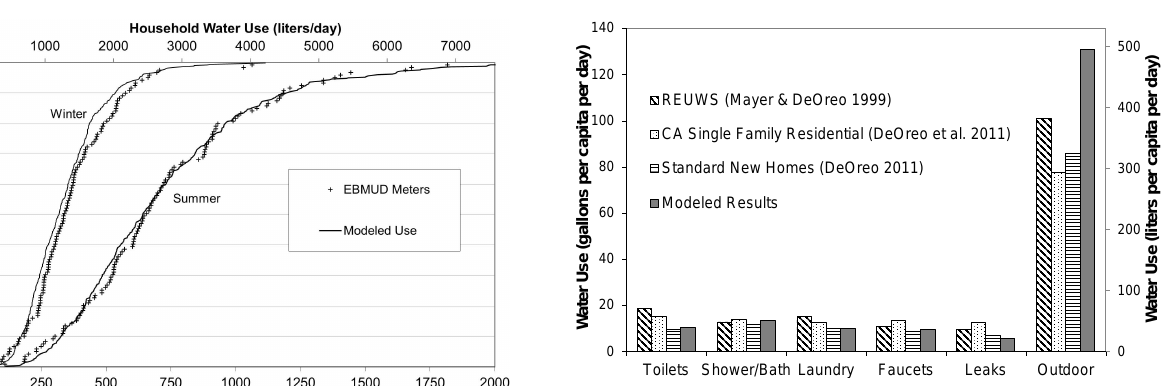
Fig. 3. Average annual modeled end uses of water compared to end use